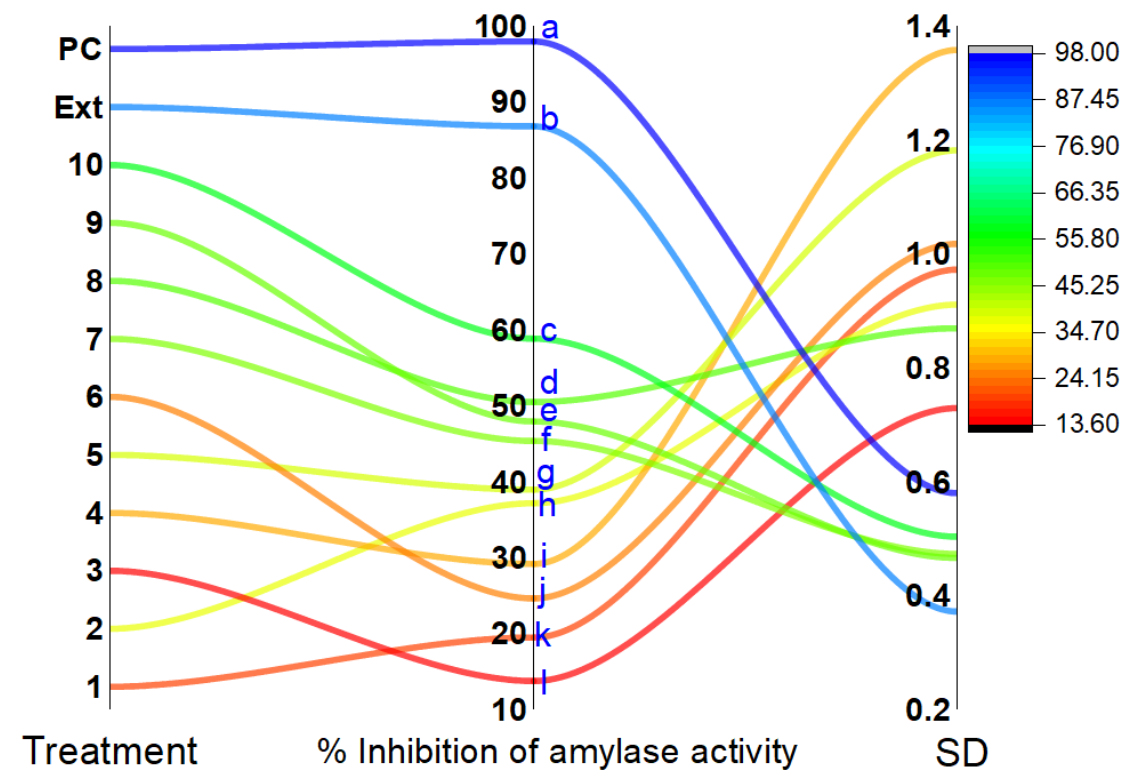
Figure 5. Effect of G . abyssinica extract (ext) and isolated bioactive compounds on α -amylase activity. Lower-case letters show a significant impact ( p ˂ 0.05). Acarbose was used as a positive control (PC).